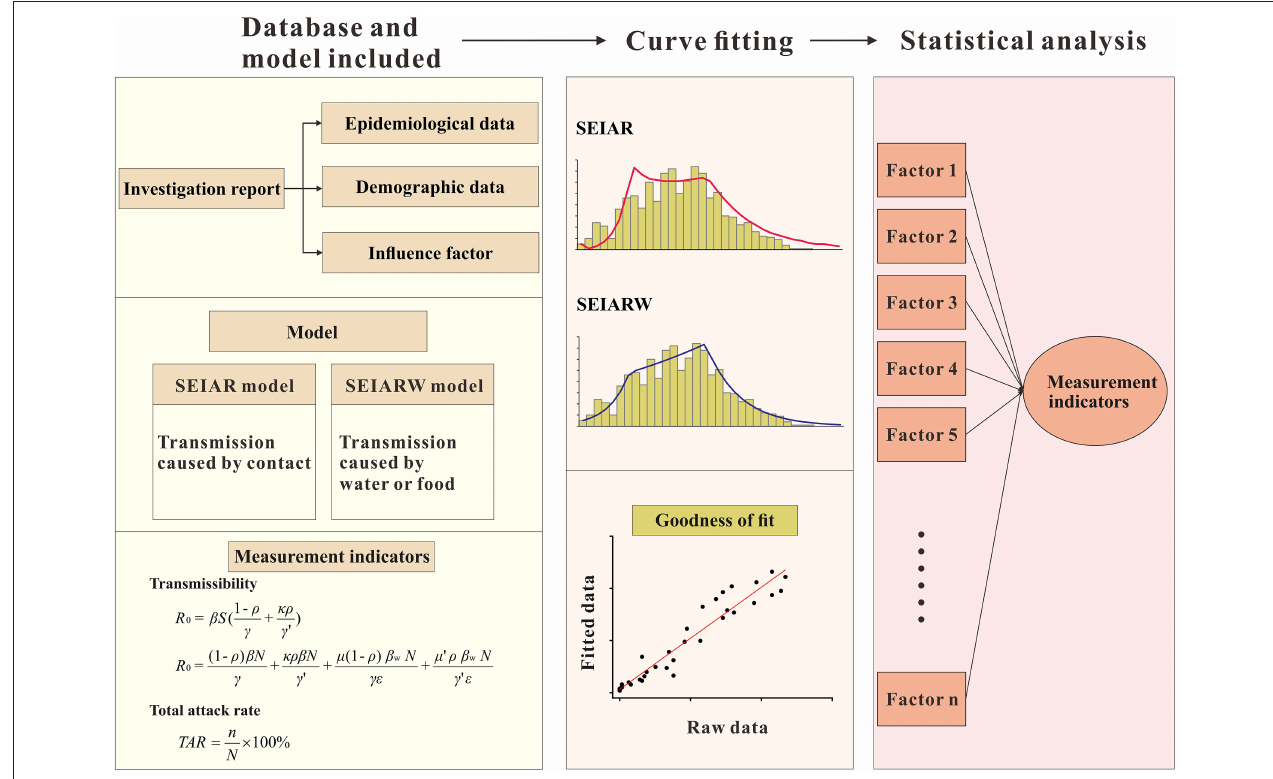
FIGURE 1 | Flow chart of norovirus outbreak research in Jiangsu